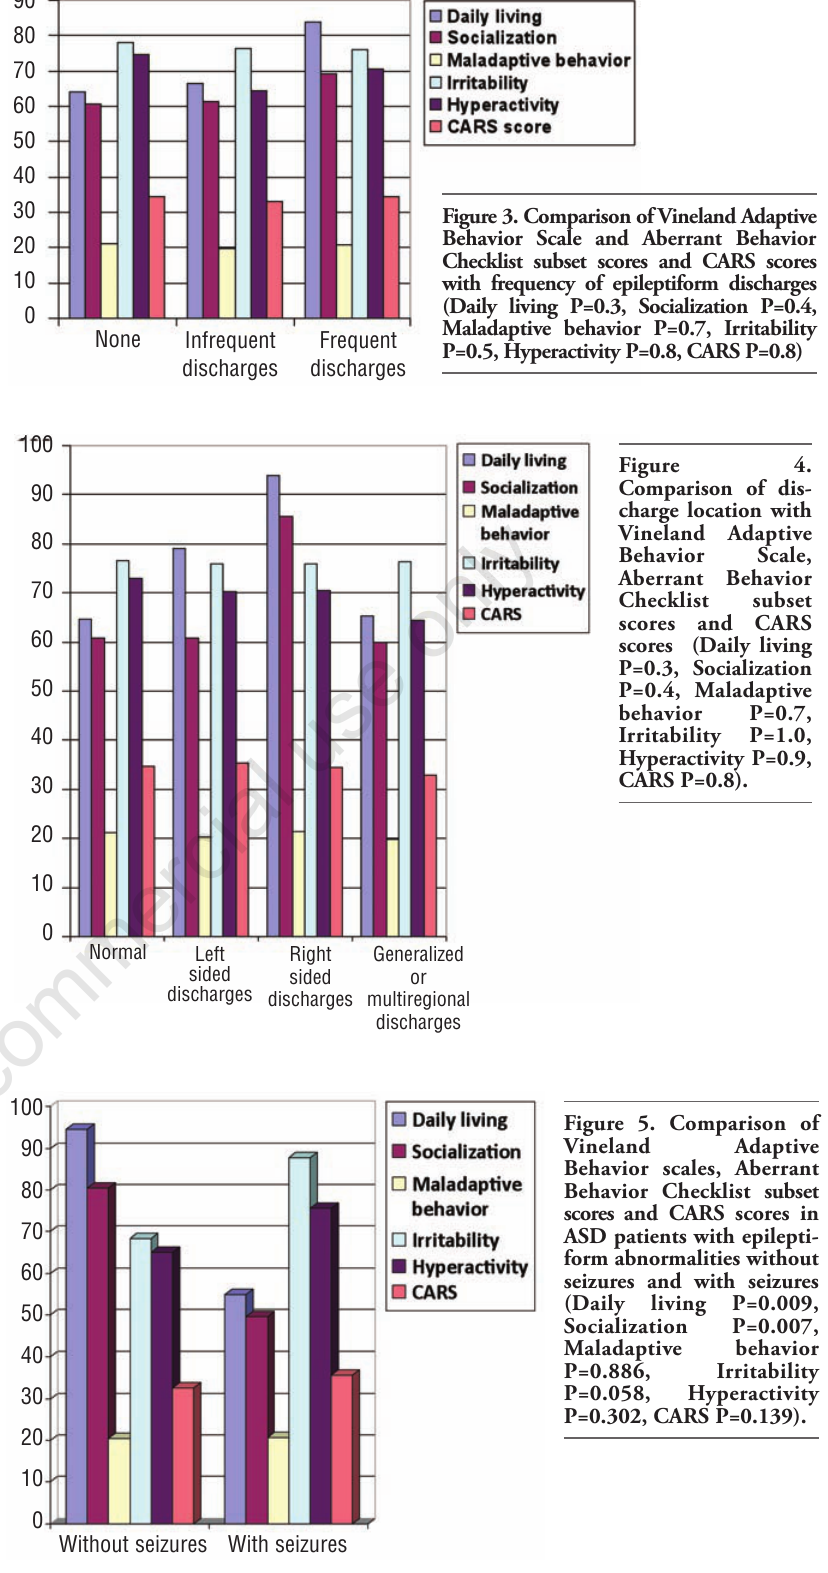
out-seizure group and 20.60±2.19 in the with- seizure group (P=0.886). Examination of sub- sets of the ABC, identified differences in irri-